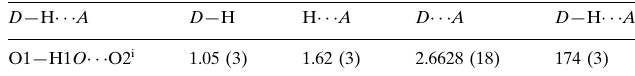
Hydrogen-bond geometry (A˚ , (cid:4)